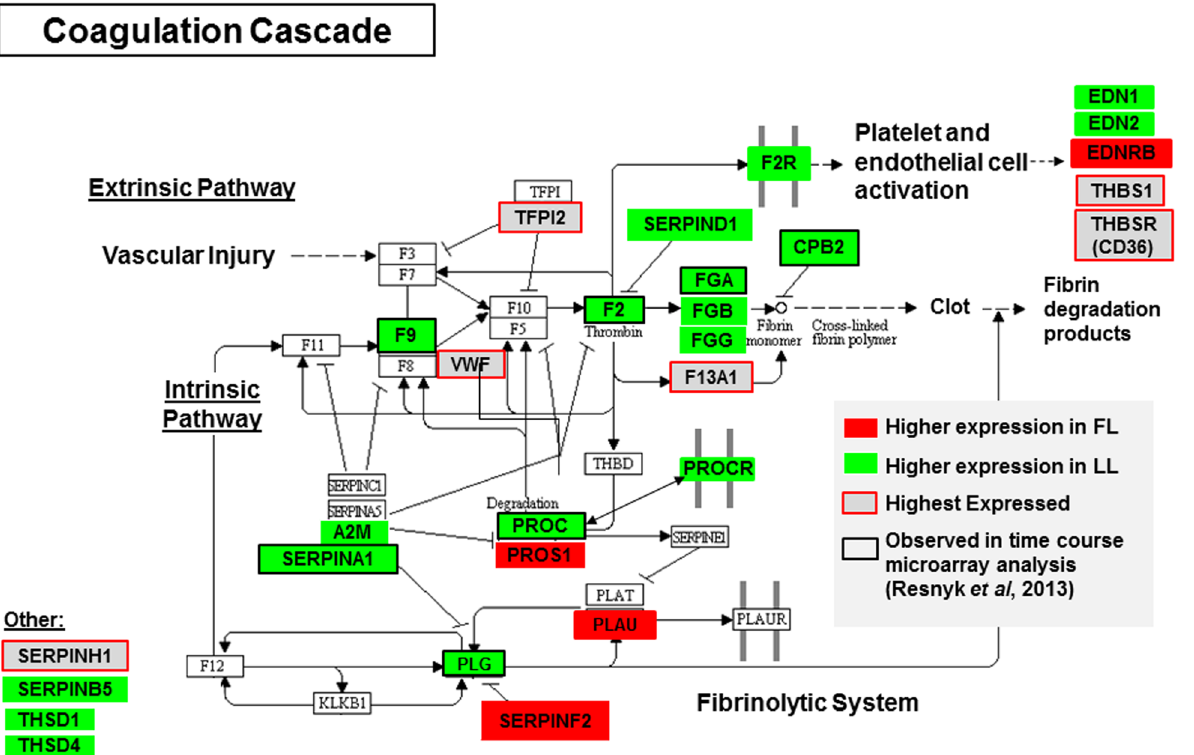
Fig 8. Prevalence of coagulation factors in abdominal fat transcriptome of FL and LL chickens. This coagulation cascade was adapted from the Complement and Coagulation Cascades (map04610) found in the Kyoto Encyclopedia of Genes and Genomes (KEGG). Reprinted from the KEGG website (http://www.genome.jp/kegg-bin/show_pathway?map04610] under a CC BY license, with permission from KEGG, original copyright [map04610, Kanehisa Laboratories, April 03, 2009]. Genes are colored based on differential gene expression (FL/LL) levels from the present RNA-Seq analysis at 7 wk and